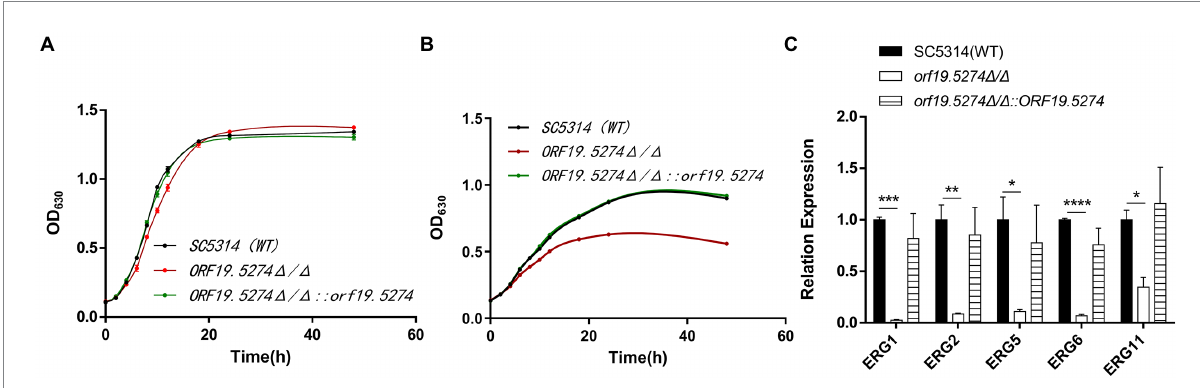
FIGURE 4 Mutant strains increase sensitivity to FLC by down-regulating ergosterol synthesis-related genes. (A) Growth and reproduction of wild, knockout, and complement strains within 48 h; (B) Growth and reproduction of wild, knockout, and complement strains within 48 h after FLC treatment with 2MIC concentration; and (C) Expression of ergosterol-related genes in SC5314, mutant, and revertant strains, respectively. The expression of the above genes in SC5314 was normalized, the remaining strains were controlled by the wild-type, and the 2 - ΔΔ Ct values were calculated. Three replicates were performed for each